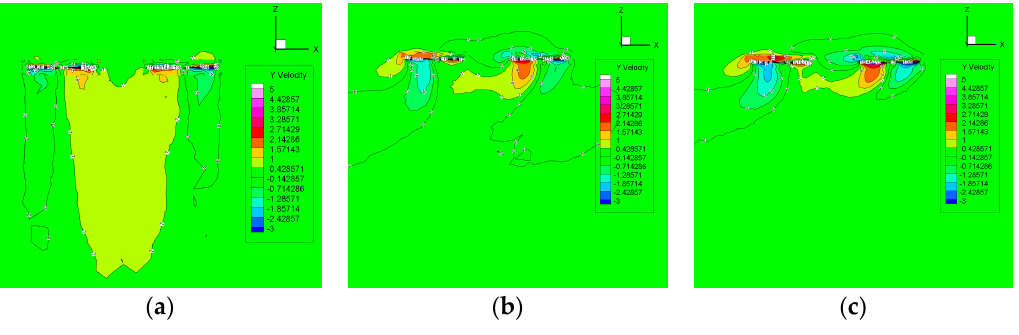
Figure 12. Velocity contour distribution ( a ) 0 m/s ( b ) 2.5 m/s ( c ) 4 m/s.